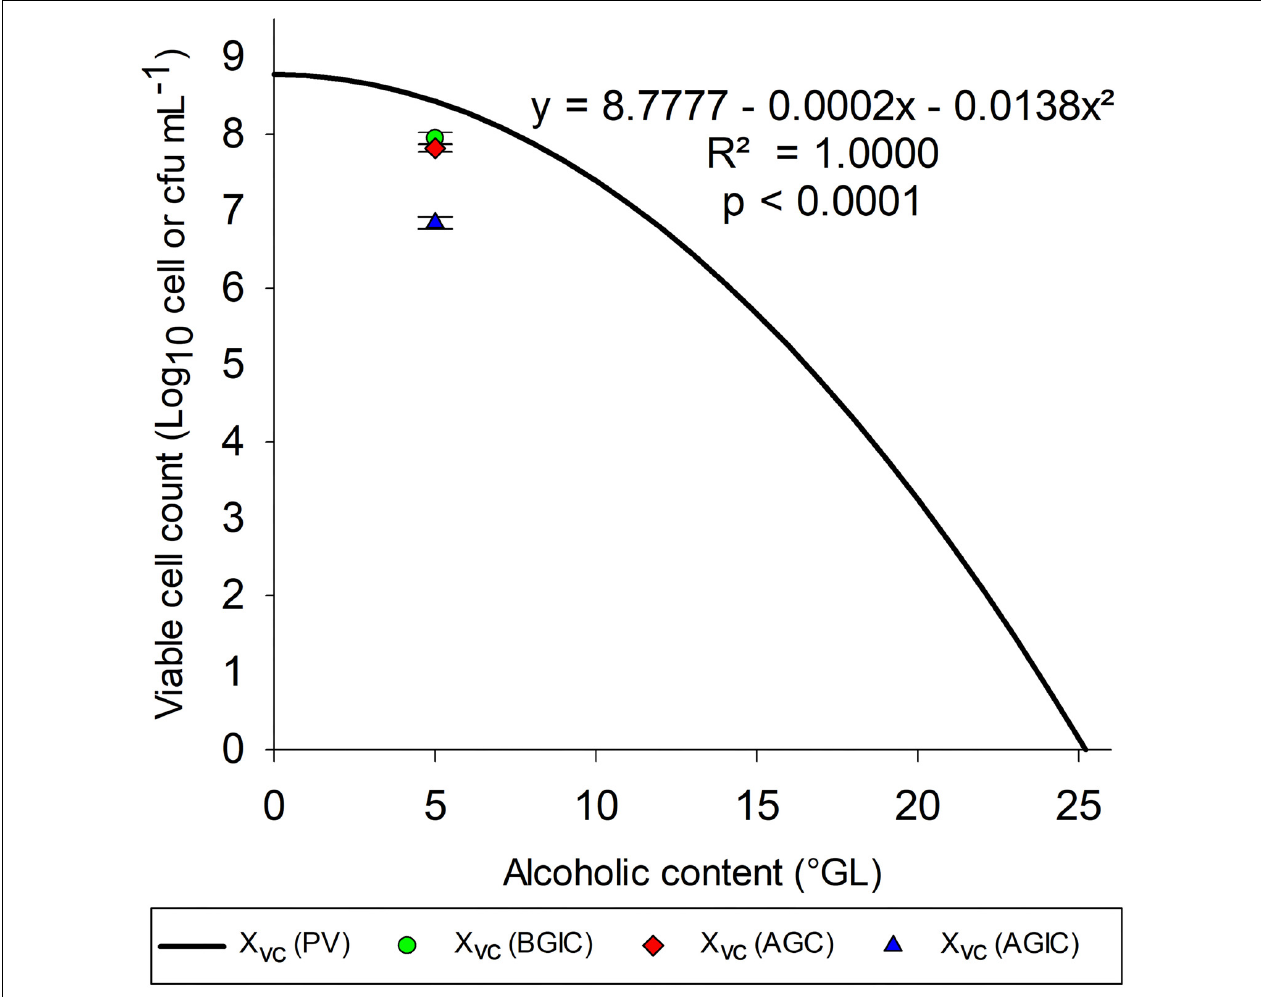
FIGURE 5 | Tolerance of S. boulardii to medium containing ethanol. X vc (PV) = viable cell concentration (Log 10 viable cells mL − 1 ) values predicted by the mathematical model with pH and temperature set to 5.5 and 24 ◦ C, respectively; X vc (BGIC), viable cell concentration before gastrointestinal conditions (Log 10 cfu mL − 1 ); X vc (AGC), concentration of viable cells after gastric conditions (Log 10 cfu mL − 1 ); X vc (AGIC), concentration of viable cells after gastrointestinal conditions (Log 10 cfu mL − 1